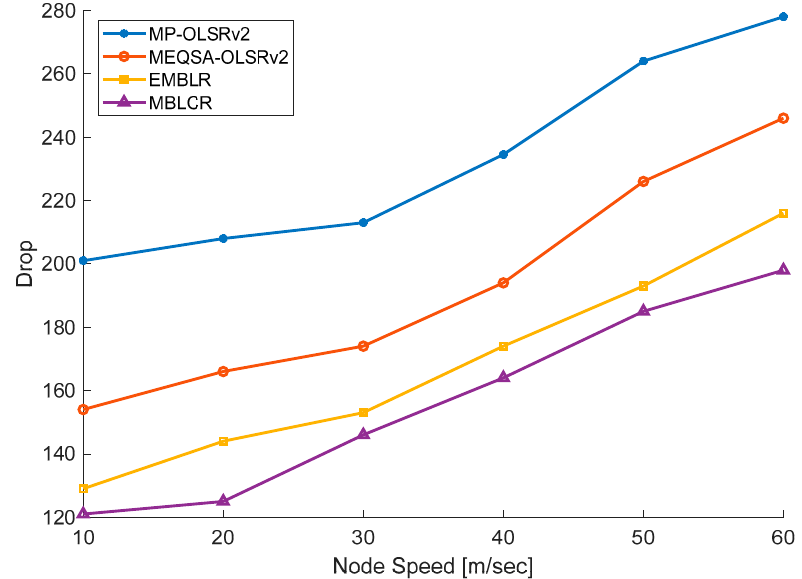
Figure 8. Packet drops with various device speed.